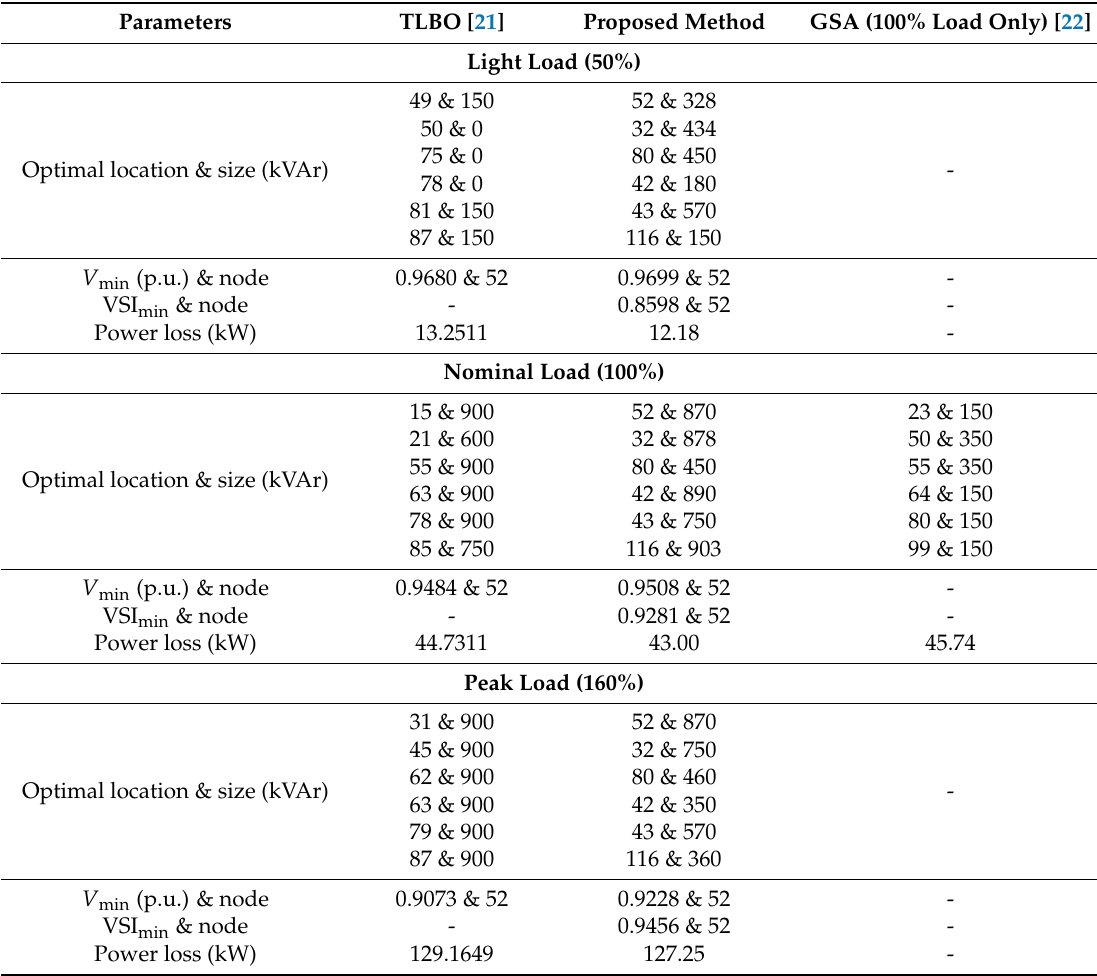
Table 4. Correlation of results of the proposed method with TLBO [21] (at loads 50%, 100%, and 160%) and GSA [22] (at 100%